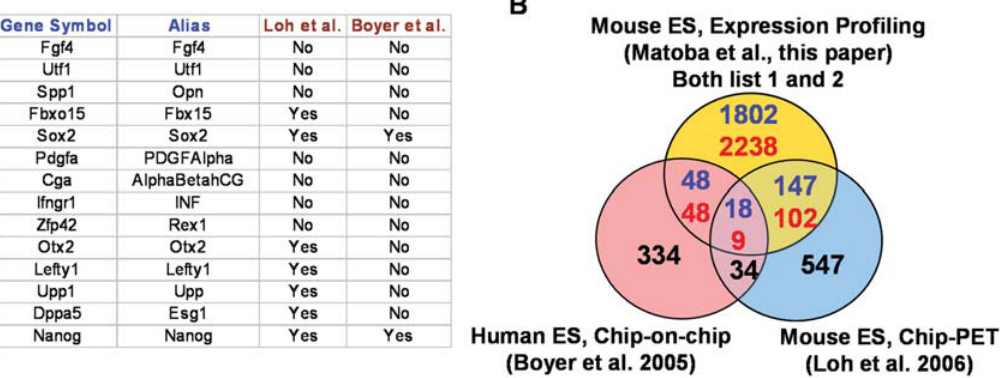
Figure 3. Delineation of Oct3/4-downstream target gene network. (A) A list of genes that have been experimentally demonstrated as the direct downstream targets of Oct3/4. Yes: genes that were also detected by the global ChIP assays. No: genes that were not detected by the global ChIP assays. Mouse homologues of human genes identified in Boyer et al . were generated using NCBI HomoloGene Build 49. (B) Comparison of gene lists obtained by the expression profiling (list 1 plus list 2) and global ChIP